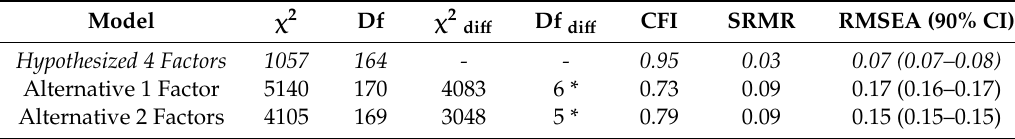
Table 2. Confirmatory factor analysis—goodness of fit